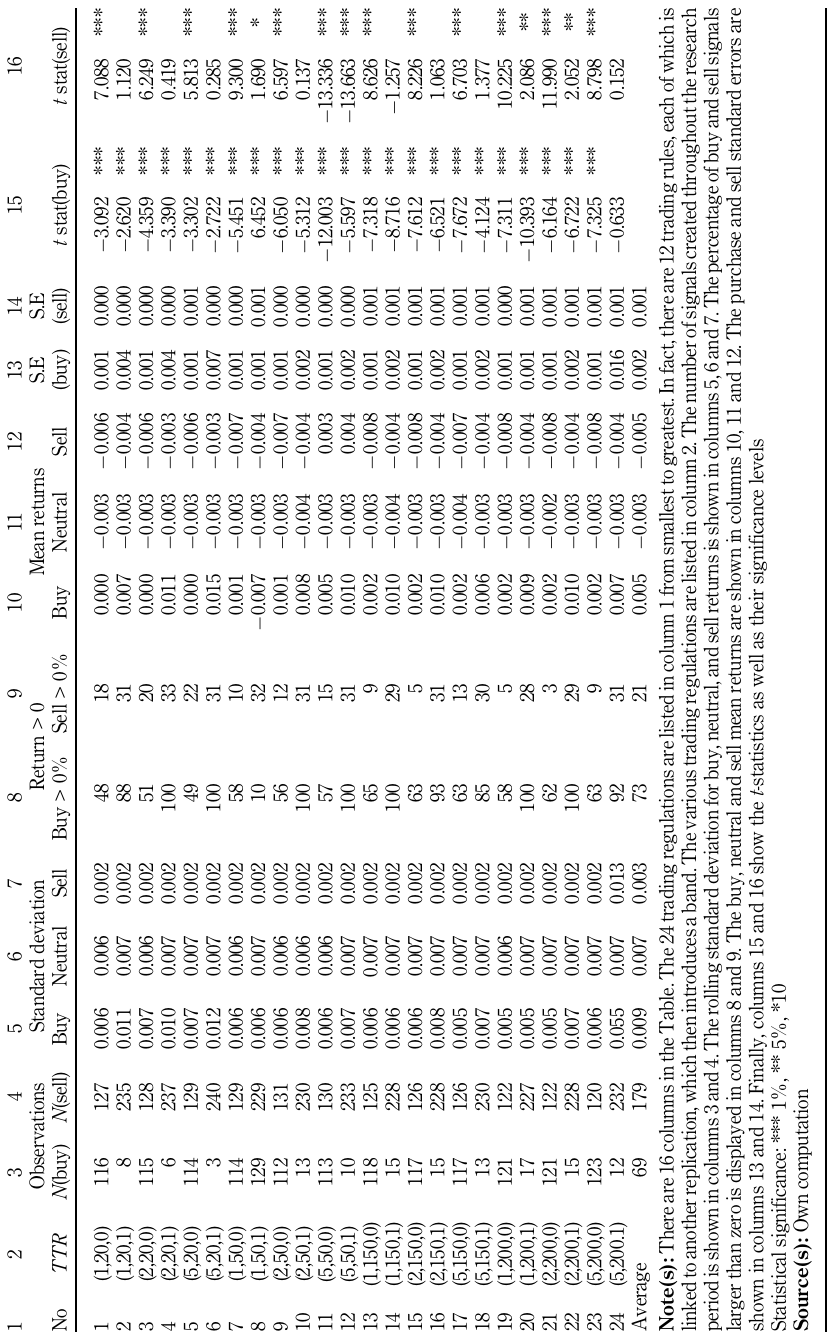
Table 4. BTC/JPY results